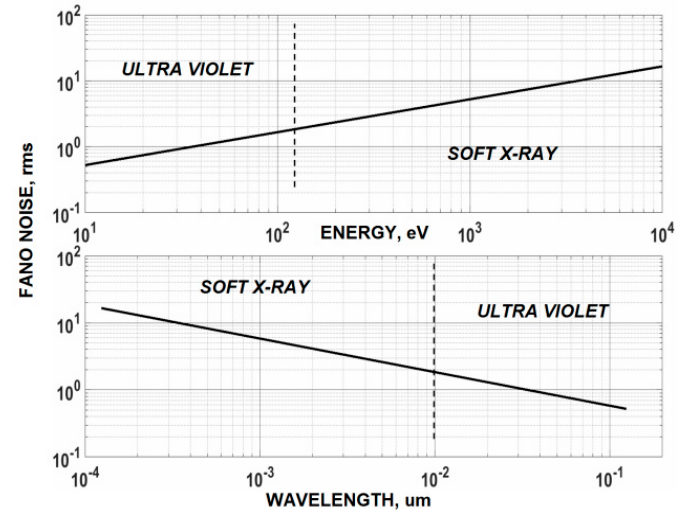
Figure 1. The plots above are used to determine the “Fano noise limit” for an imager with a given read noise. For example, a read noise of one carrier rms will cover the soft X-ray and extend into the UV at wavelength of 0.03 um (~40 eV).